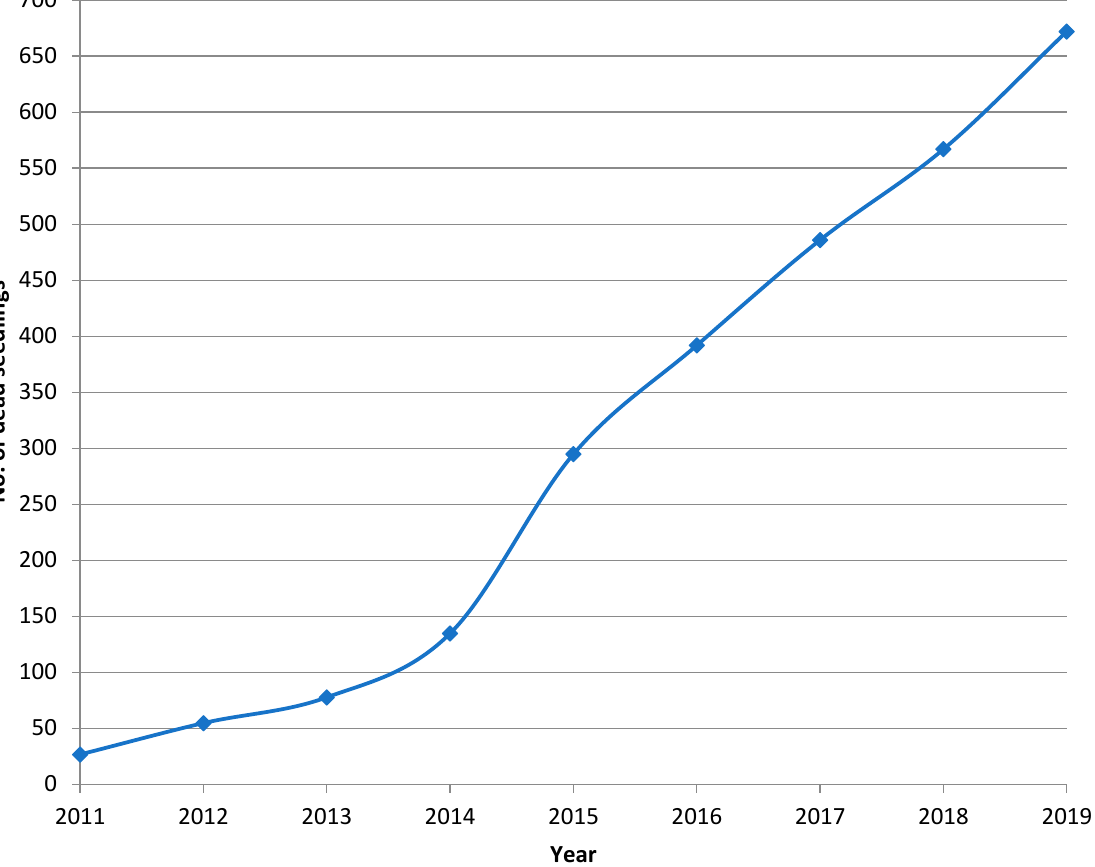
Figure 2. Cumulative mortality of pine seedlings infected by Heterobasidion annosum s.s. (verified and probable infections) on the 1.2 ha regeneration area in the period 2011–2019.